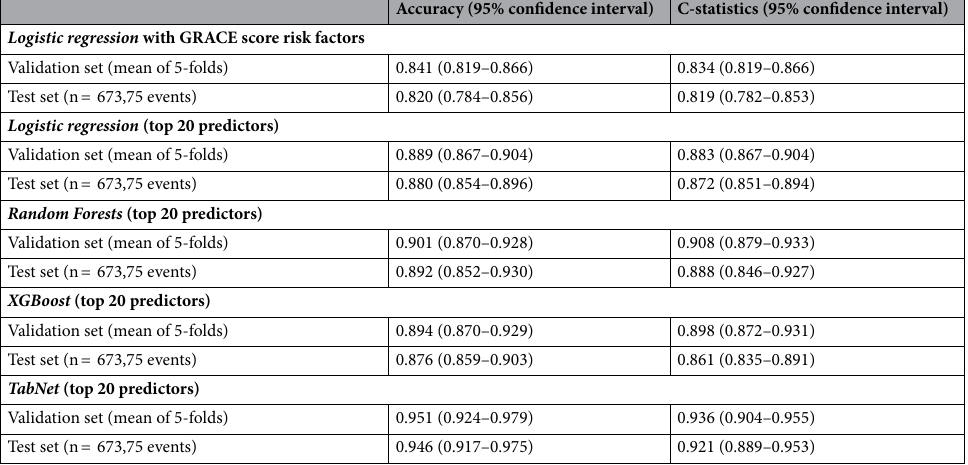
Table 2. Accuracy and C-statistics for short-term window models in predicting in-hospital death or recurrent ischemic events in 2242 individuals with premature ACS (55 years old or younger), total number of events = 180 ( in-hospital CV deaths = 39, and MI = 141).